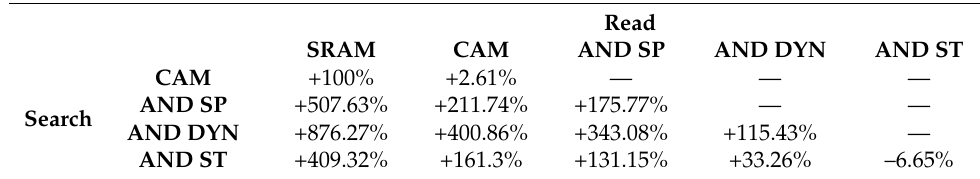
Table 10. Percentage differences between the write and search energy–delay products among the arrays. Each value corresponds to the increase, expressed in percentage, in the energy–delay product of the memory on the corresponding row with respect to the one of the memory on the corresponding column. The data are extracted from Table 3.